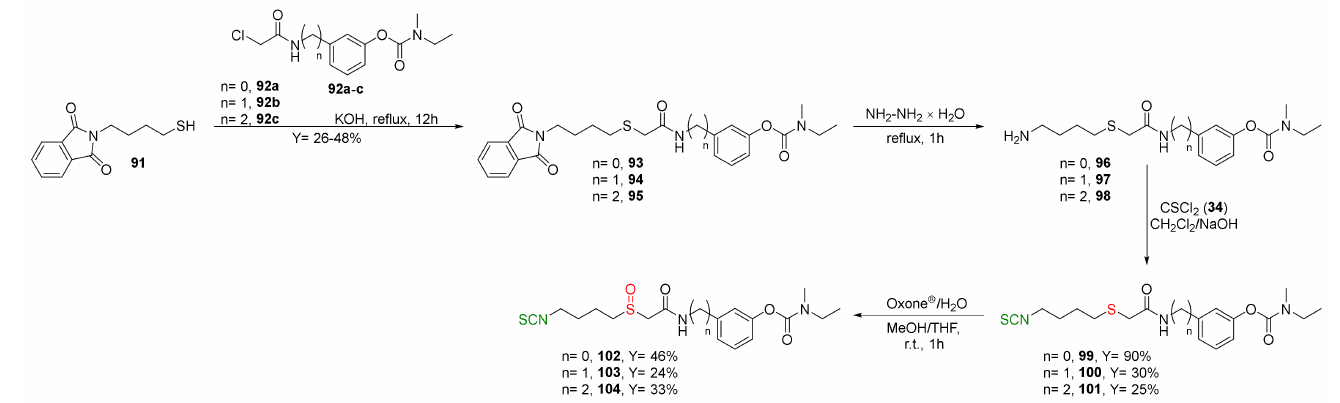
Figure 25. Synthesis of erucin and SFN-rivastigmine hybrids 99 – 104 .